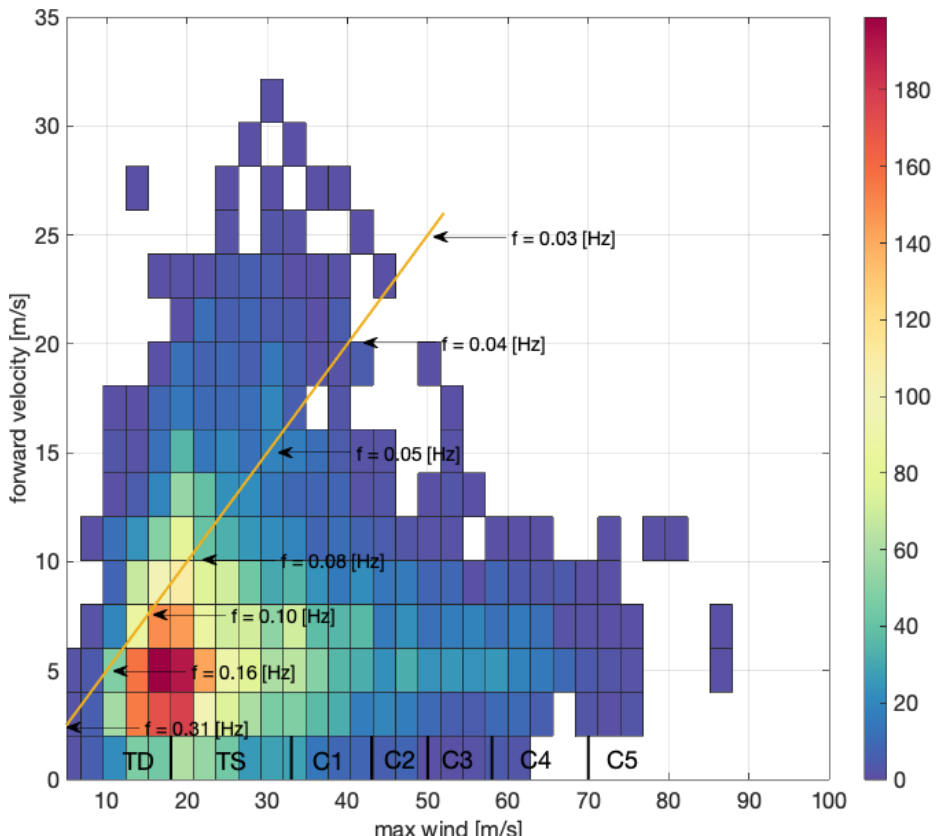
Figure 2. The joint distribution of maximum sustained winds and forward velocity; the counts are shown in the color scale. Additionally indicated are the S-S categories on the x-axis with black lines. An orange line shows the wave phase speed (celerity) that corresponds to wind speed on the x-axis and the wave group speed that corresponds to the translation velocity. A few frequencies in the wind-wave band are indicated along the